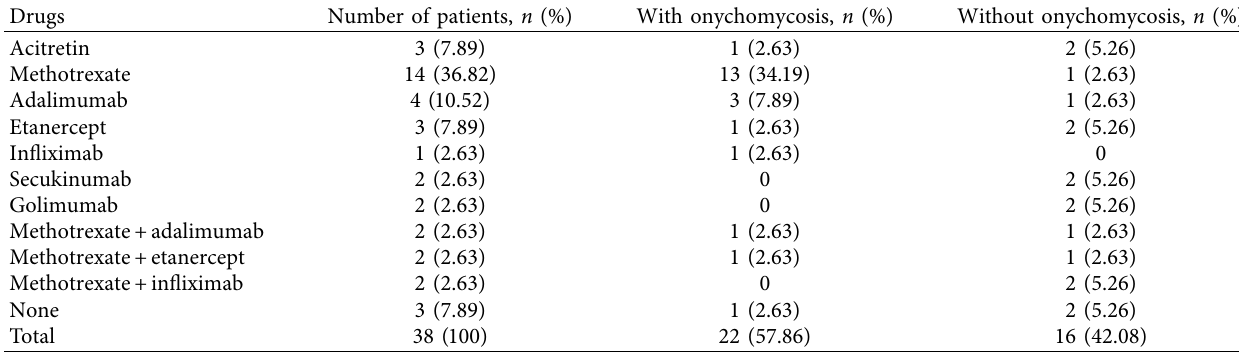
Table 4: Drugs used to treat patients with psoriatic disease with and without onychomycosis. Drugs Number of patients, n